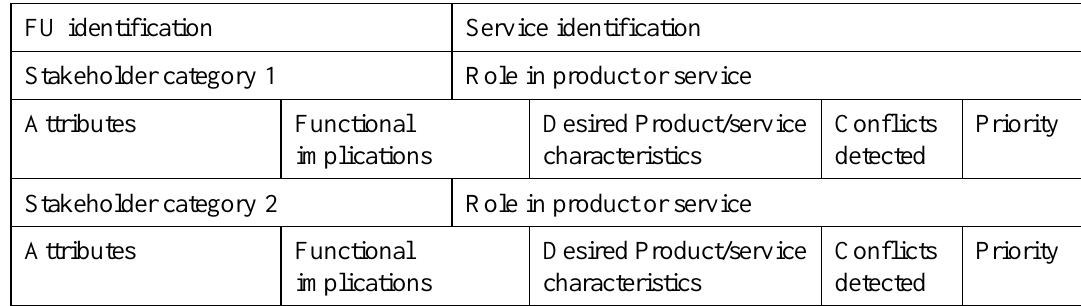
Table 1. Requirements for user profile, simplification of User Fit tool, template UA1, and